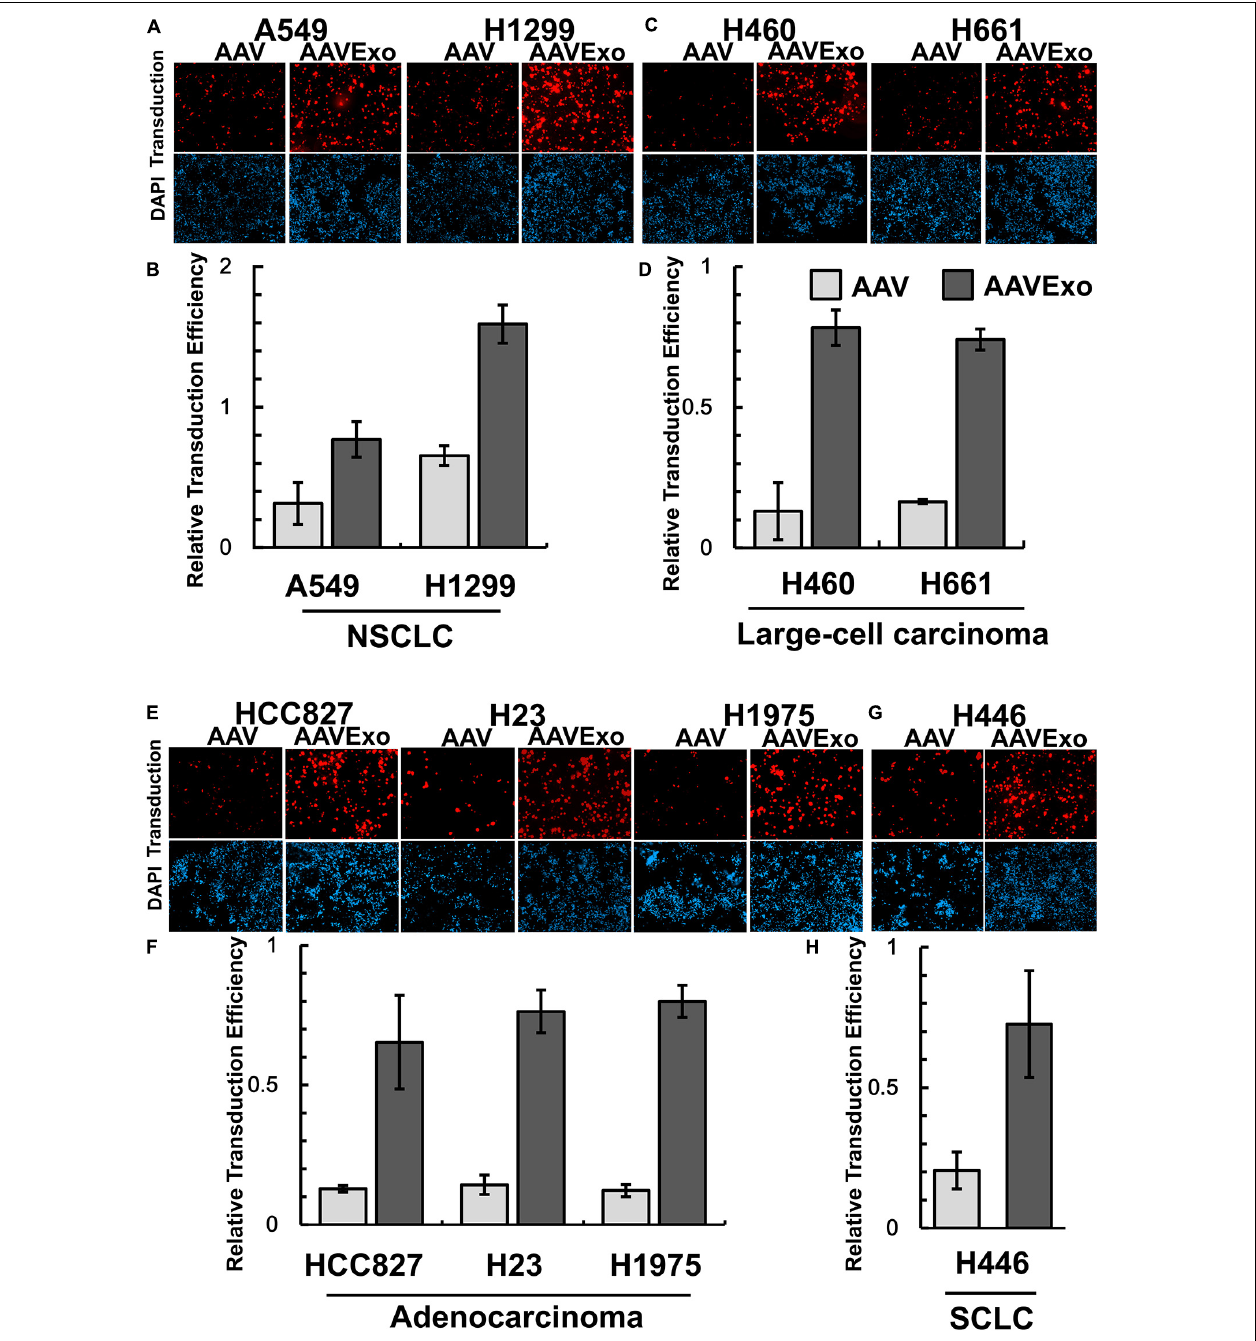
FIGURE 4 | AAVExo has high capacity for gene delivery in vitro . A couple of selected lung cancer cell lines representing (A,B) common NSCLC, (C,D) large-cell carcinoma, (E,F) adenocarcinoma, or (G,H) SCLC were infected by equal titer (3E6 g.c. for a 48-well plate) of AAV6Exo-mCherry or pure AAV6-mCherry for 3 days. Cells were stained with DAPI before fluorescence microscopy imaging. The mCherry intensity was quantified and normalized to DAPI and plotted via Microsoft Excel. This experiment was reproduced biologically for three times, and the mean with standard deviation was